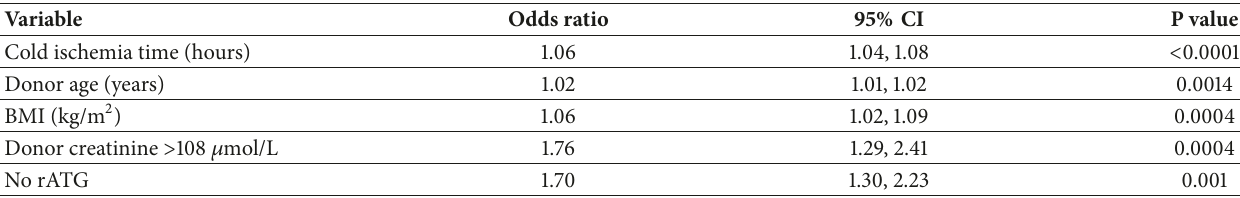
Table 3: Variables included in a predictive model for DGF based on 1,844 deceased-donor transplants since 2007 [12].